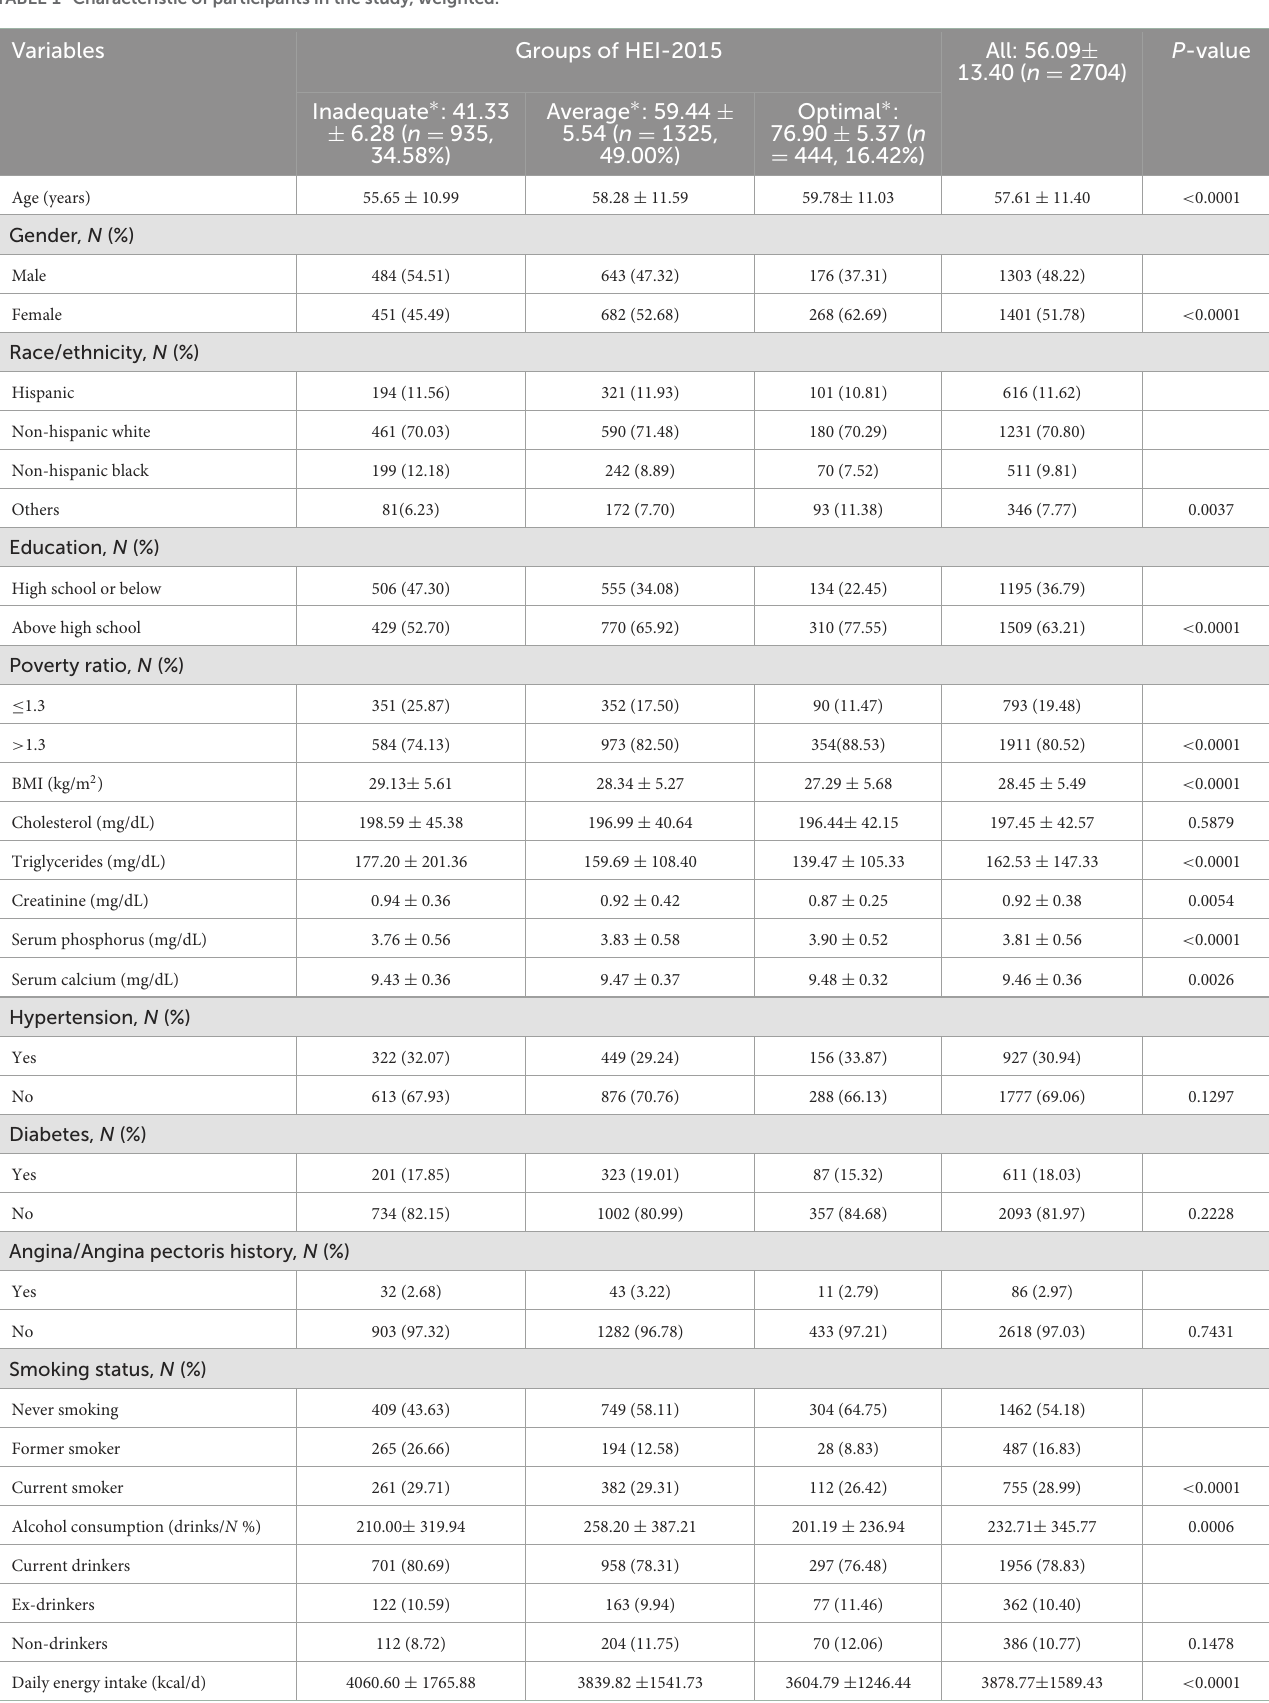
TABLE 1 Characteristic of participants in the study, weighted.